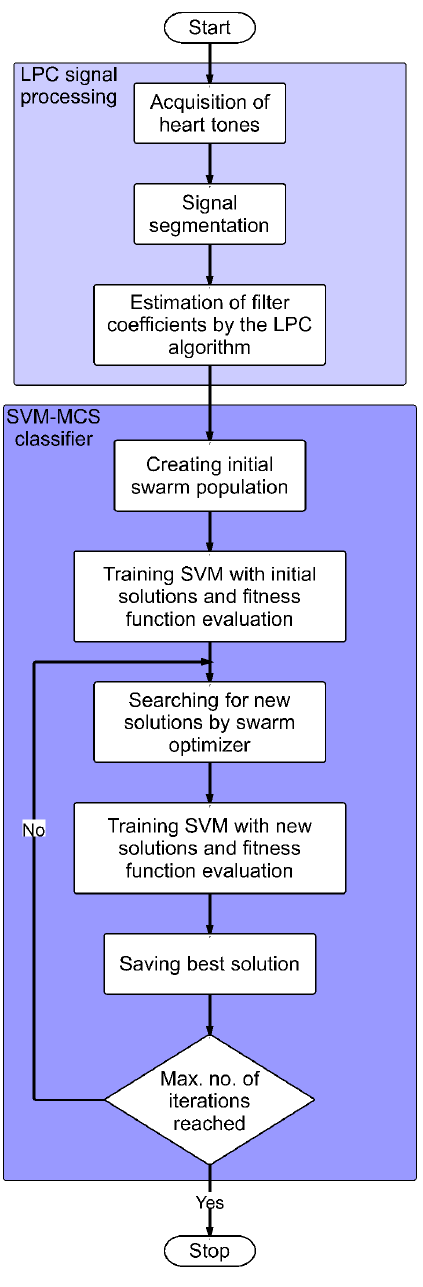
Figure 1. A flowchart of the hybrid LPC-SVM-MCS system training process. The system first collects PCG signals and performs their segmentation to extract useful information for LPC estimation. Then the training process commences where the Modified Cuckoo Search algorithm optimizes parameters of a Support Vector Machine